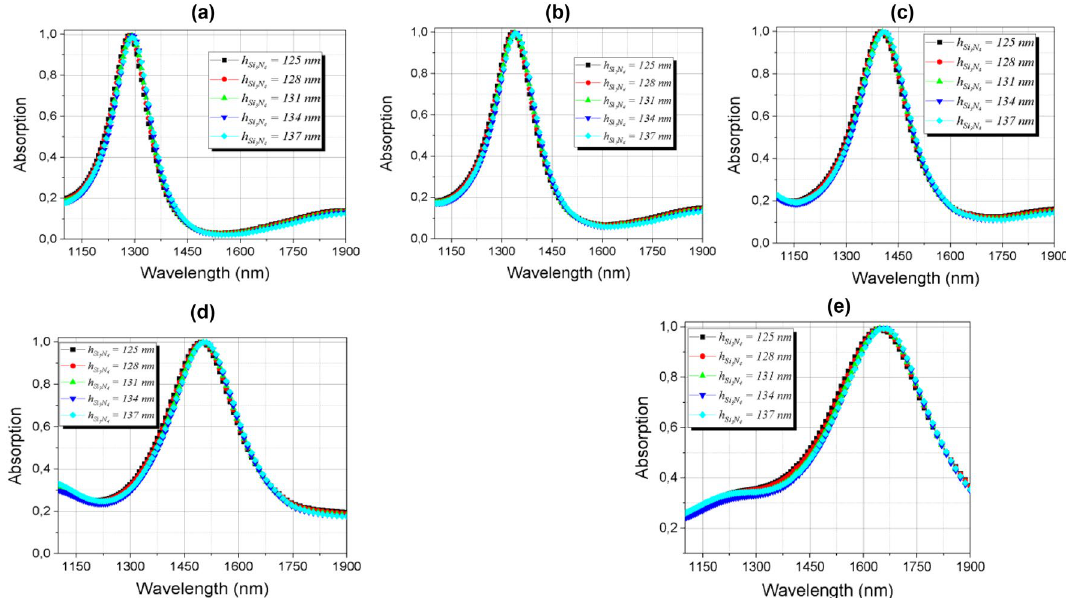
Figure 11. Absorption dependence of the dielectric thickness of Si 3 N 4 h Si3N4 in the range of 1100–1900 nm ( a ) amorphous; ( b ) semi-crystalline (m = 25%); ( c ) semi-crystalline (m = 50%); ( d ) semi-crystalline (m = 75%); ( e ) crystalline phases.